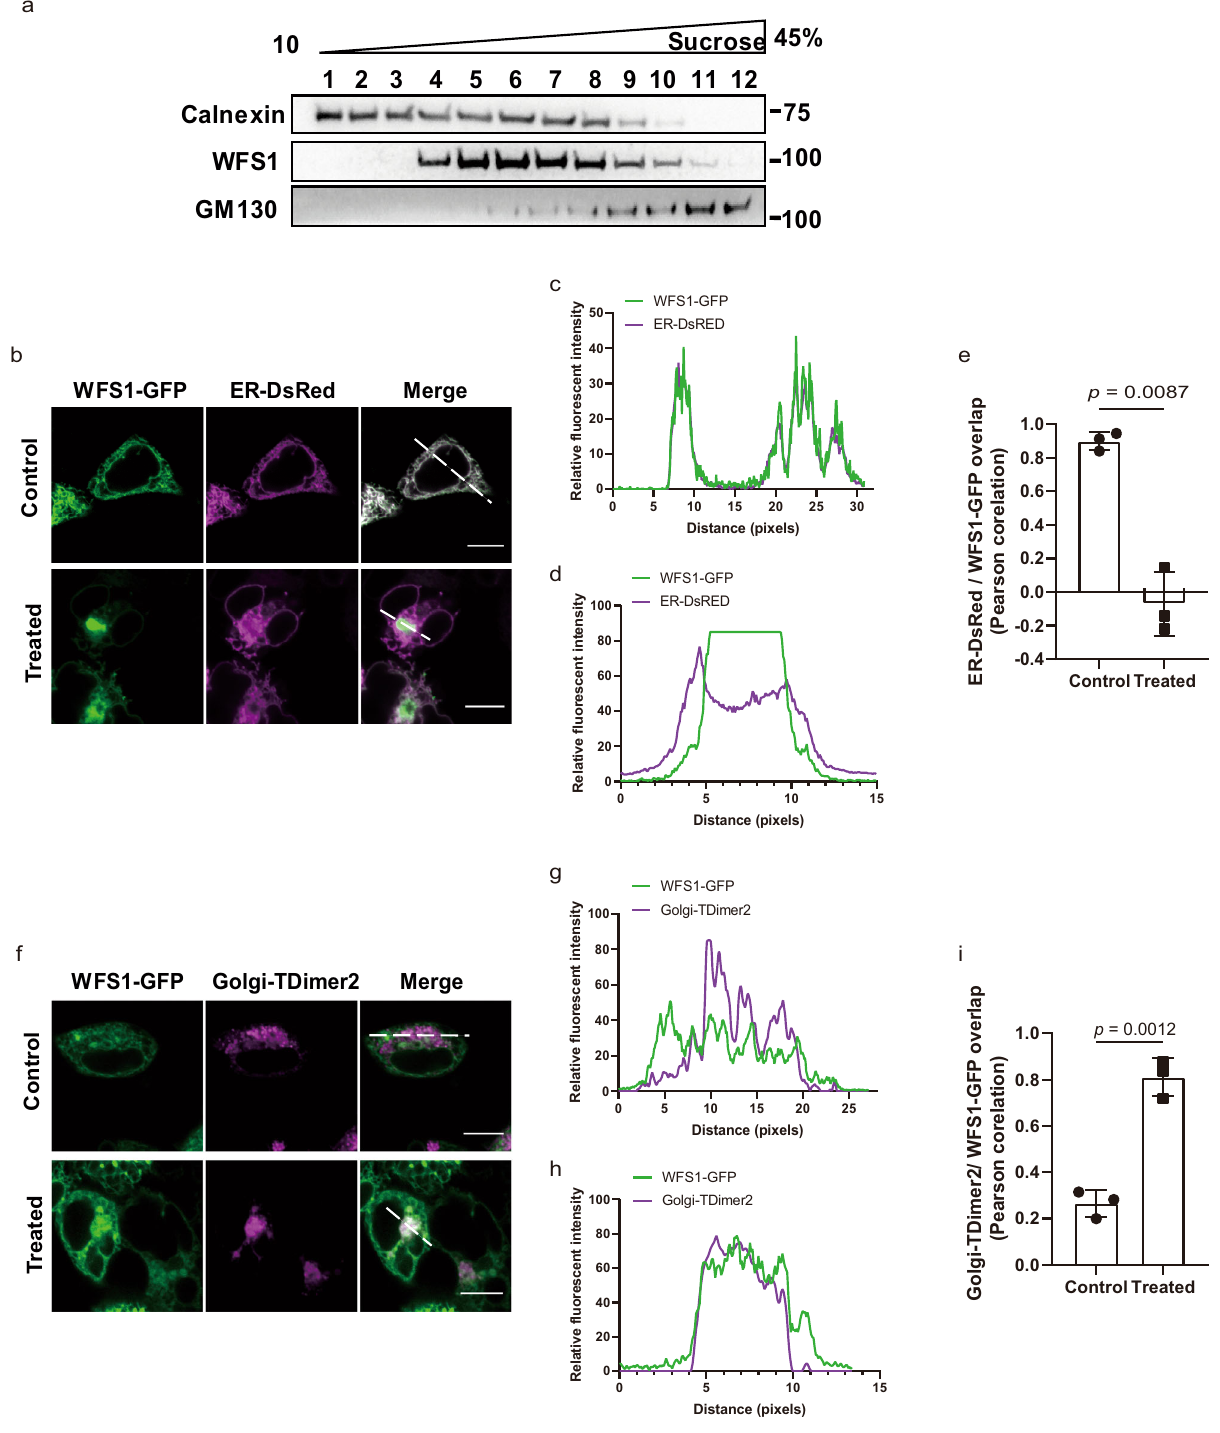
Fig. 4 WFS1 traf fi cs from the ER to the Golgi. a WFS1 distributes in the ER and Golgi fractions. Lysates from INS1 cells were subjected to sucrose gradient centrifugation and IB. ER fractions were marked by calnexin and Golgi fractions were marked by GM130. Molecular weights are in kDa. n = 3